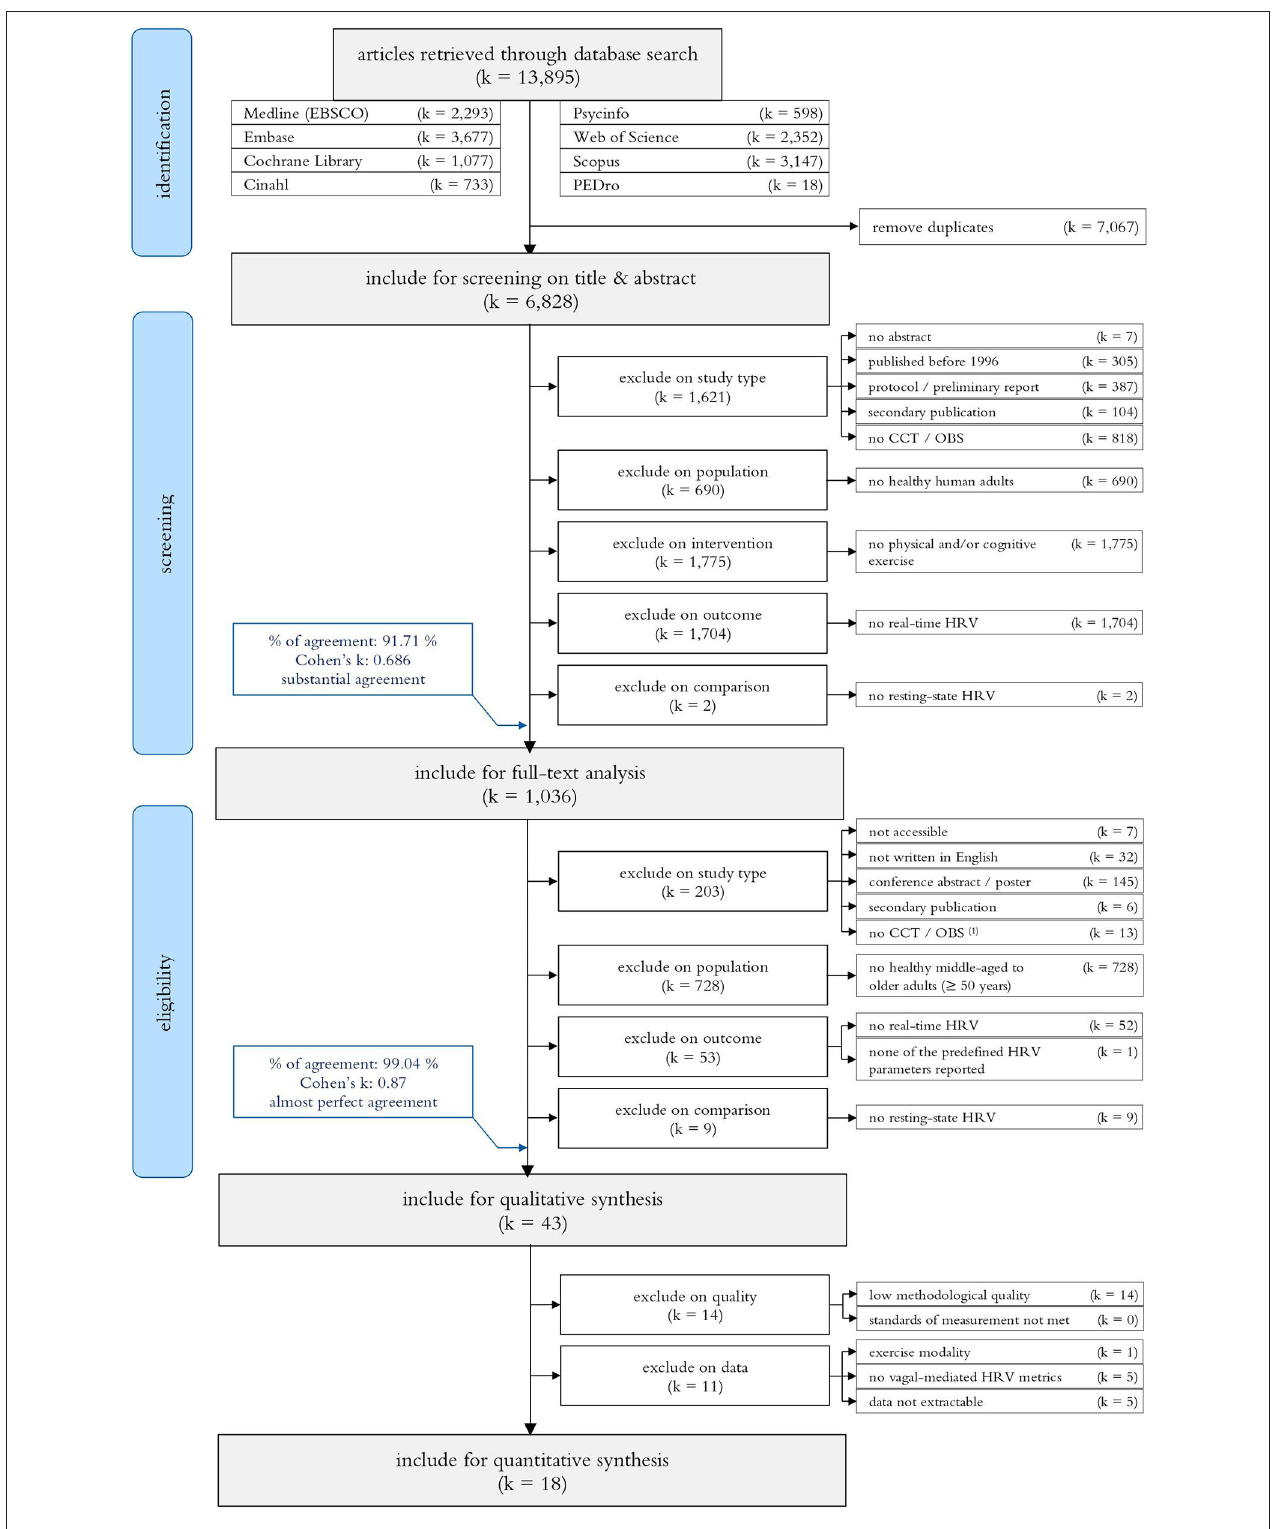
FIGURE 1 | PRISM flow diagram of the search-, screening- and study selection process. CCT, Controlled Clinical Trial; OBS, Observational Study.